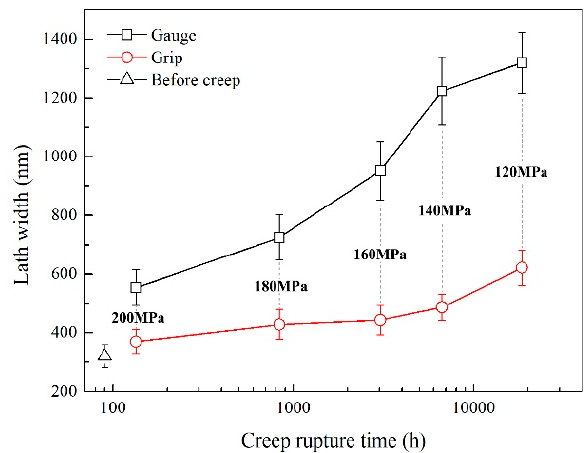
Figure 8. Lath width of 9Cr-3W-3Co creep ruptured samples.